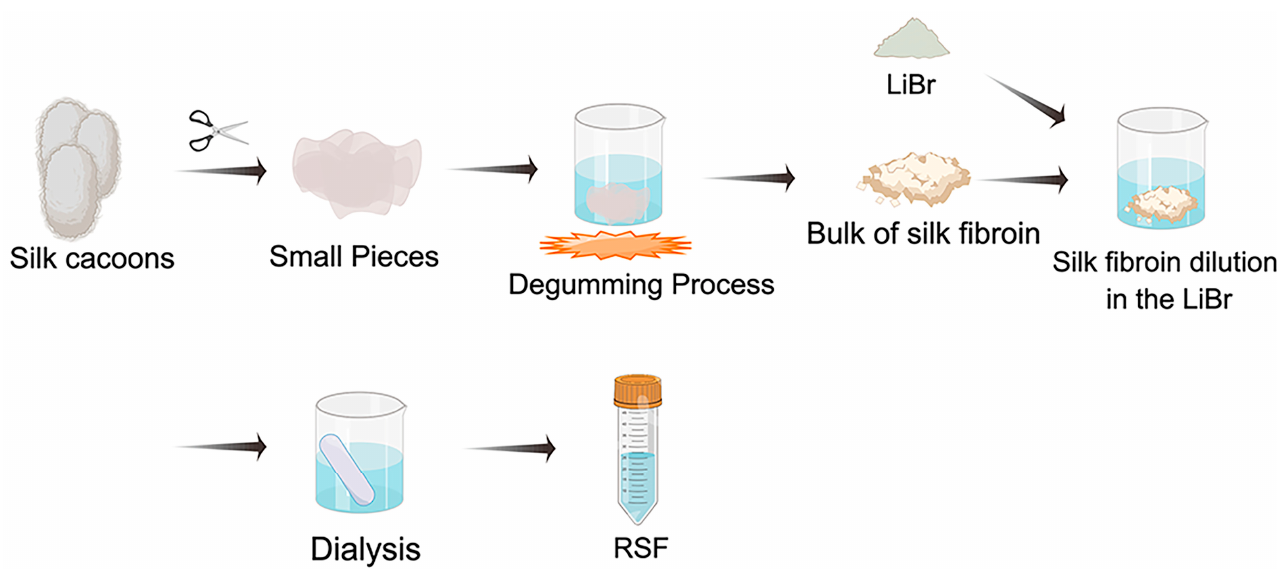
Figure 2. A schematical representation of obtaining regenerated silk fibroin (RSF) solution. Silk cocoons are cut into small pieces, which are purified from sericin by boiling them in degumming agents. The bulk of SF was obtained by drying overnight. RSF was formed by dissolving the bulk of SF in LiBr and then dialyzing.